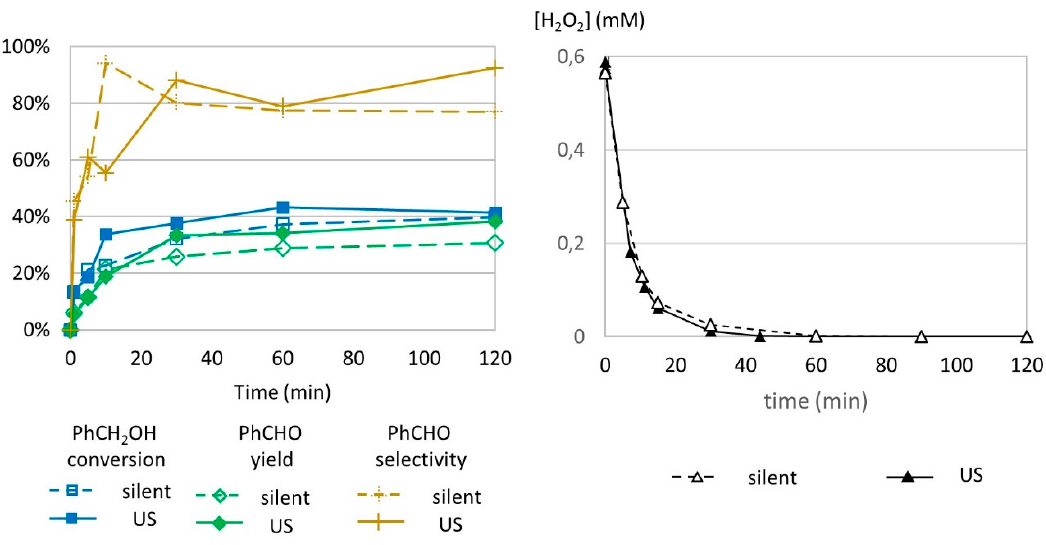
Figure 7. Oxidation of PhCH 2 OH as a function of time in silent condition and under US irradiation (547 kHz). Reaction conditions: 571 mM PhCH 2 OH, 1 molar eq. H 2 O 2 ; 1% molar eq. FeSO 4 , 56.1 mL H 2 O, 70 °C (left) and monitoring of H 2 O 2 over time. Reaction conditions: 584 mM H 2 O 2 ; 5.5 mM FeSO 4 ; 5.988 mL water (right). Silent conditions: Argon bubbling; US conditions: 547 kHz, P acous = 55.5 W L − 1 h − 1 .